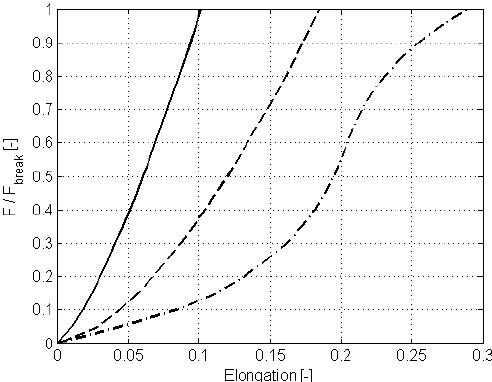
Figure 6. Mooring line load-elonation curves for polypropylene (—) and braided nylon, stiff (- -) and soft ( ¨´¨